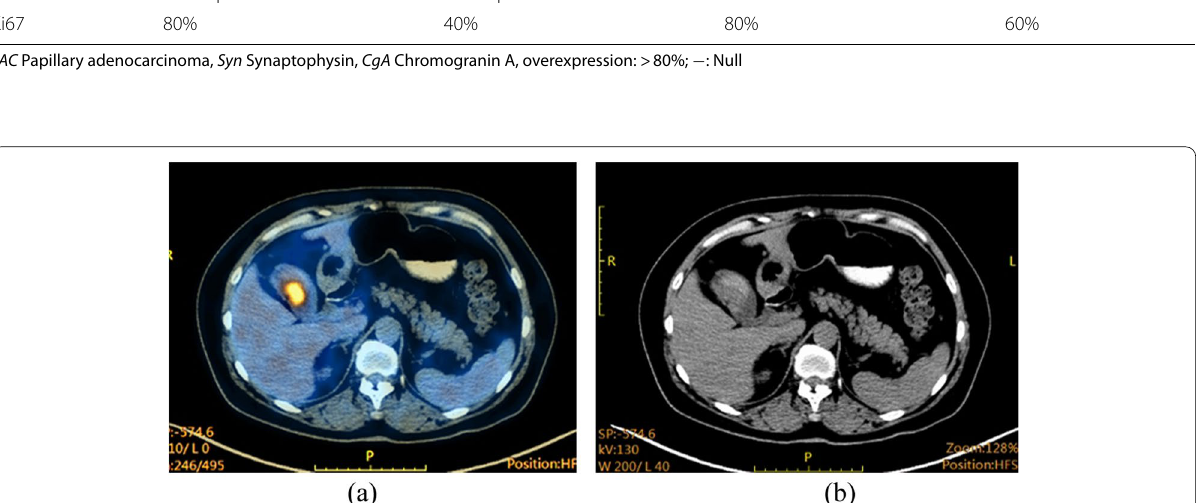
Fig. 3 Case 2: 18 FDG-PET/CT examination. a An indistinct hypointense mass and scattered slightly hyperdense calcified shadow in the gallbladder were observed. b FDG accumulated in the gallbladder